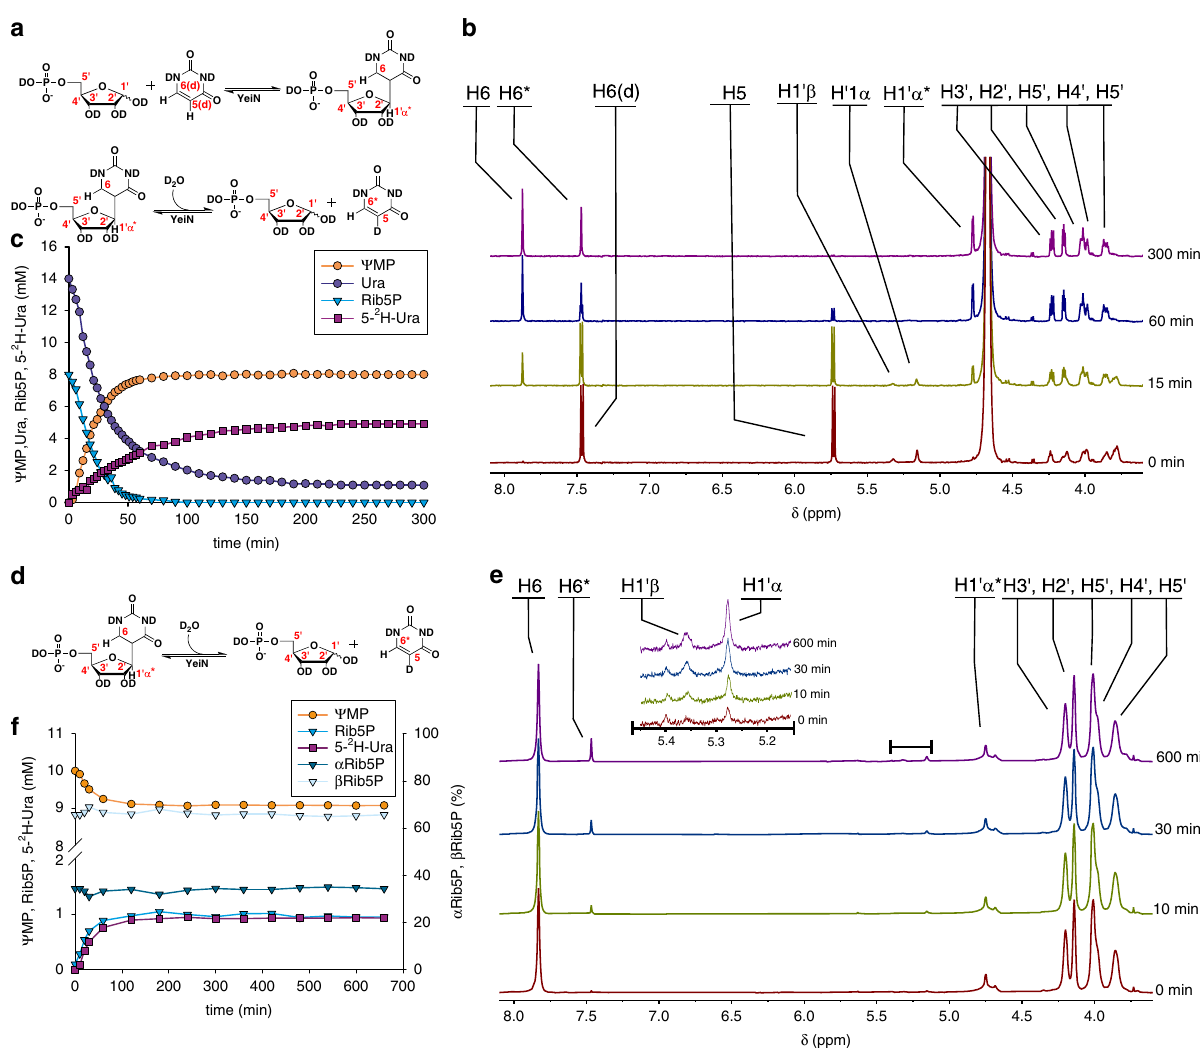
Fig. 4 Enzymatic synthesis and hydrolysis of Ψ MP monitored by 1 H-NMR. a Scheme of enzymatic synthesis of Ψ MP. Solvent deuterium is incorporated into Ura ( 12 ) C5 due to enzymatic hydrolysis of Ψ MP. b 1 H-NMR traces of Ψ MP synthesis from 14 mM Ura ( 12 ) and 8 mM D -Rib5P ( 1 ), using 3 µ M YeiN. c Time course of Ψ MP synthesis as determined from the NMR spectra ( n = 1). d Scheme of solvent deuterium incorporation into Ura C5 due to the enzymatic hydrolysis of Ψ MP e 1 H-NMR traces of hydrolysis of Ψ MP (10 mM) by 3 µ M YeiN. f Time course of Ψ MP hydrolysis as determined from the NMR spectra ( n = 1). Relative amounts of β - D -Rib5P and α - D -Rib5P are displayed on the secondary